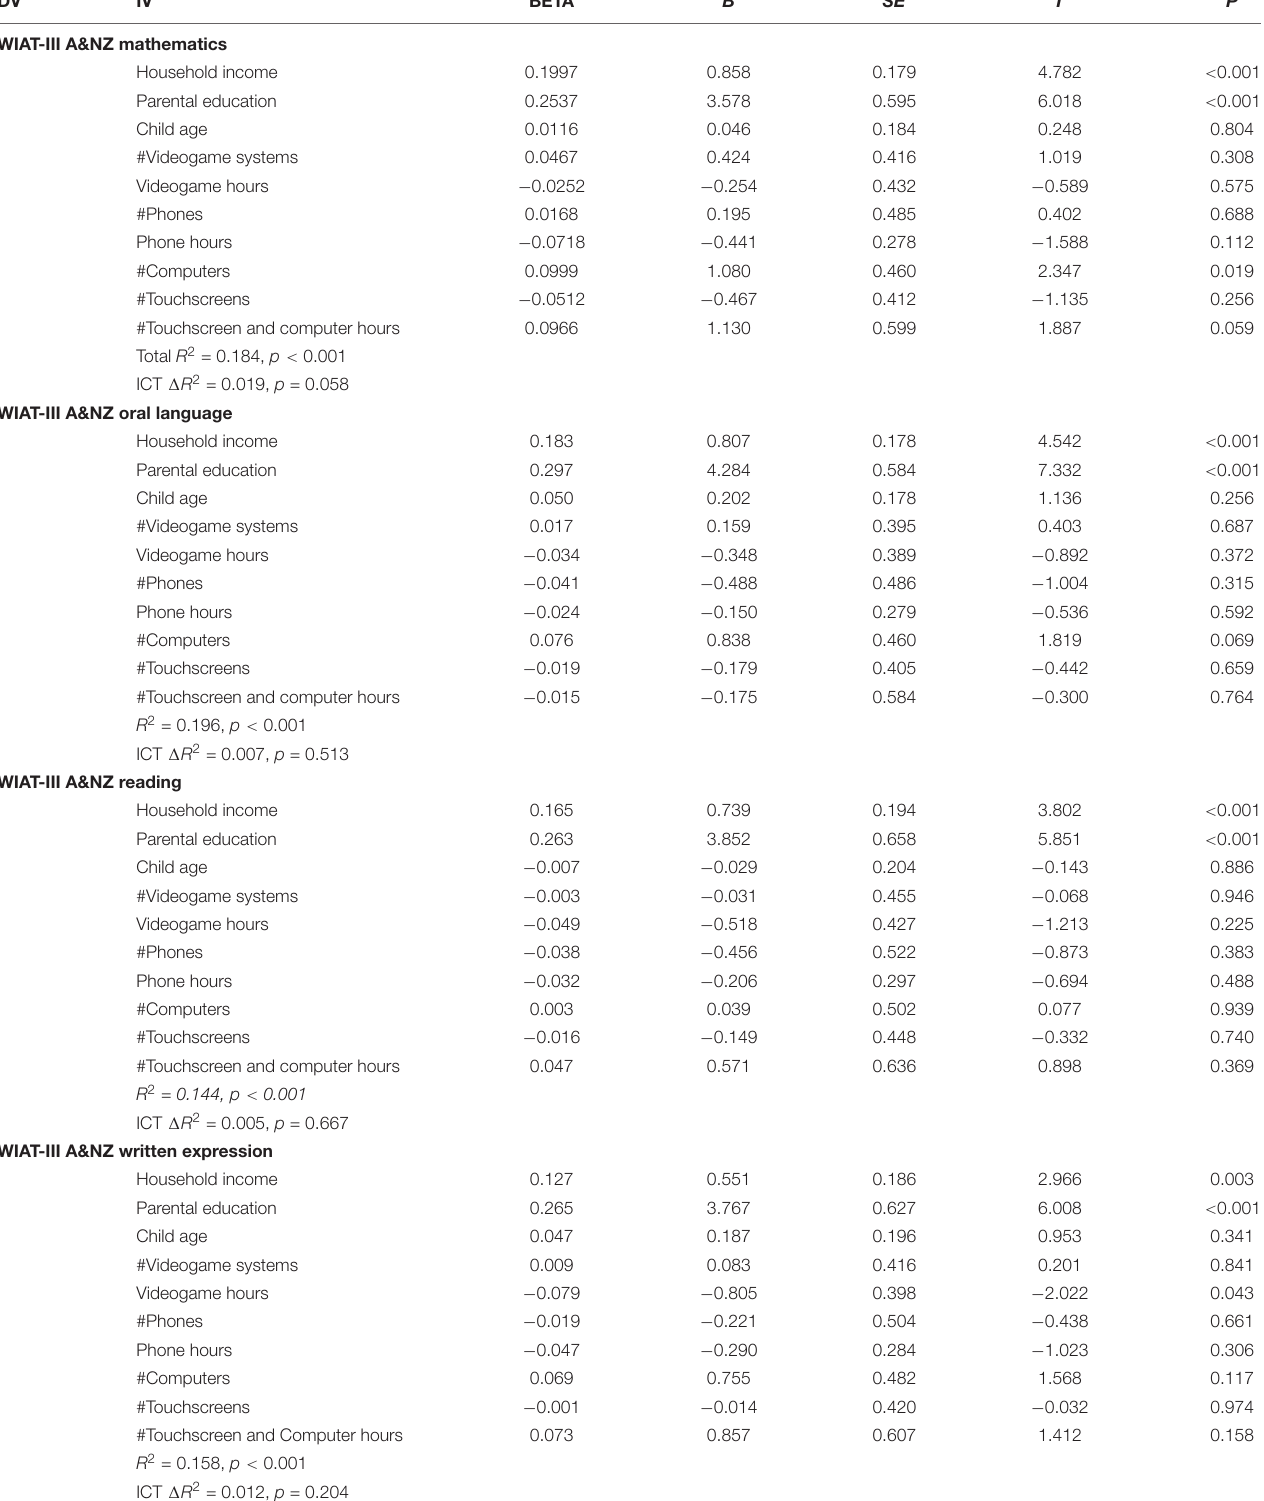
TABLE 3 | Sequential multiple regression of ICT Access on WIAT-III A&NZ Academic